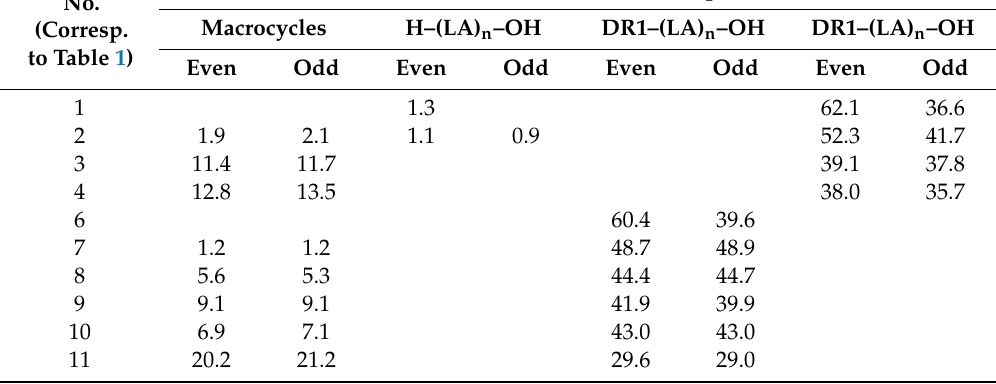
Table 2. Fraction of number of molecules in population (by MALDI-ToF) of PLA obtained by ROP of L -LA initiated by zinc and magnesium complexes with Disperse Red 1 (DR1) and Disperse Red 13 (DR13) as co-initiators.